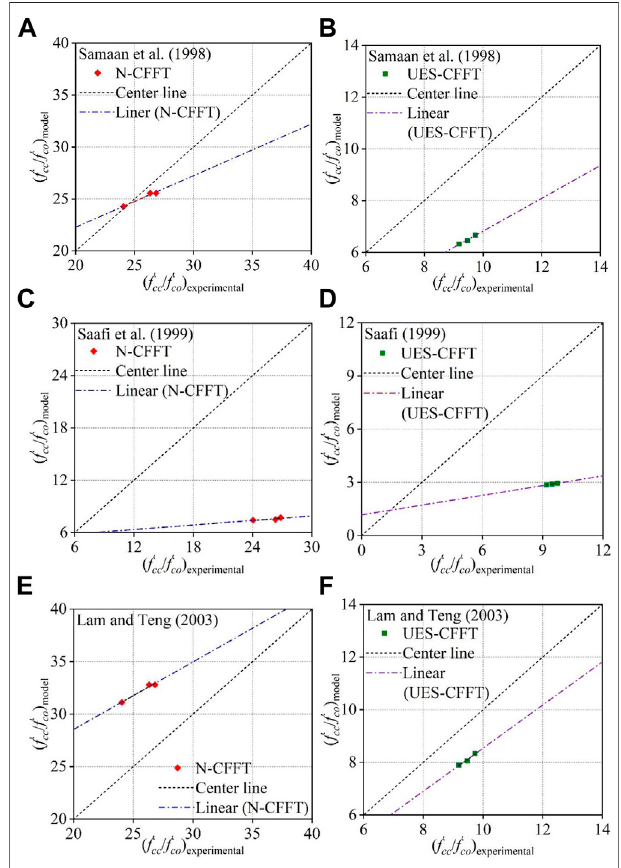
FIGURE 9 | Performance of models in predicting strength enhancement